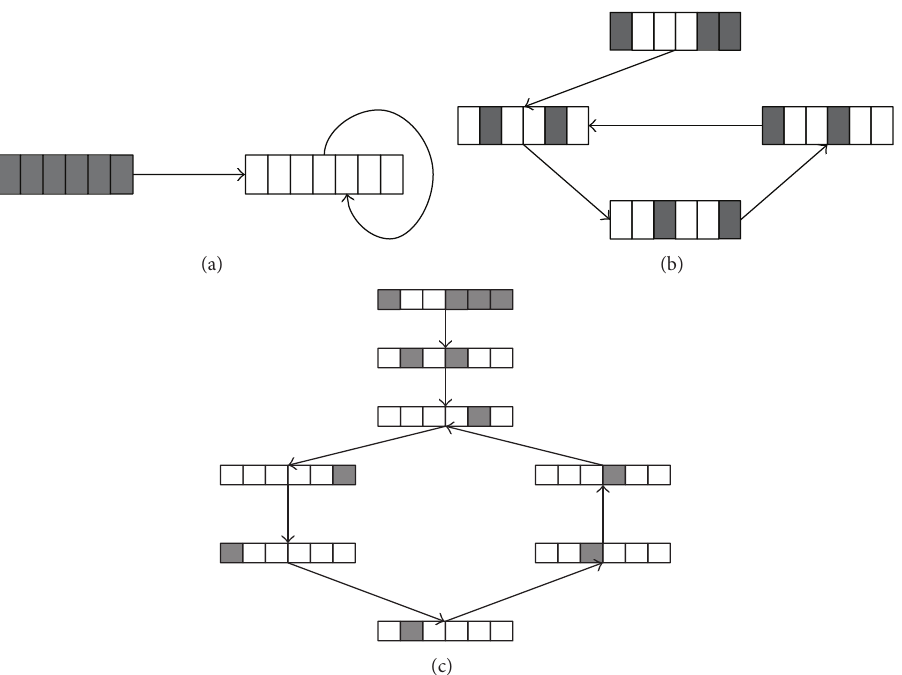
Figure 3: Several attractors of rule 24, where 𝐼 = 5 , and the white lattice stands for 0 and the black for 1.